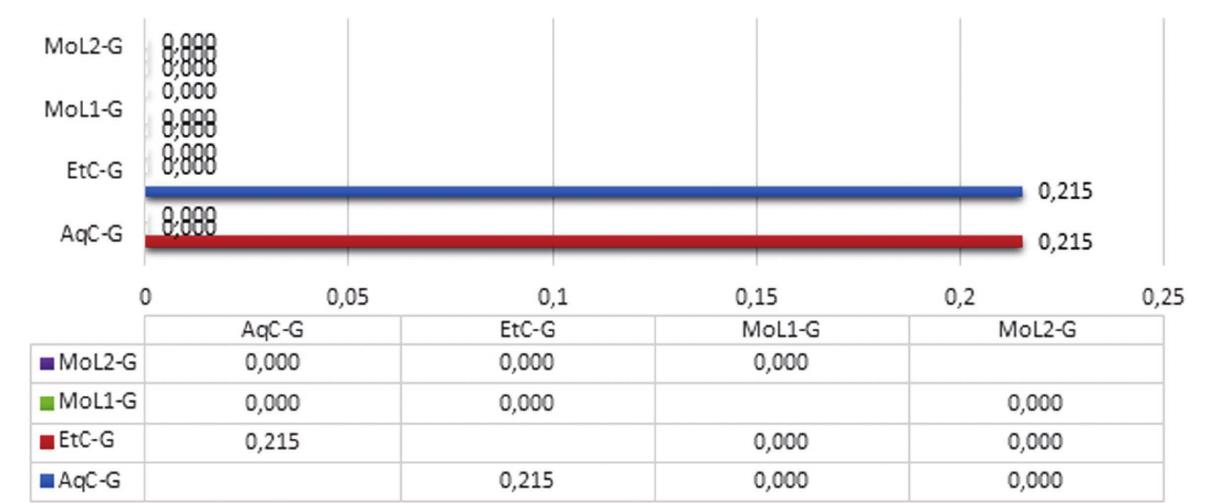
groupsFigure 3. Mean Differences of Bcl2 expressions between two